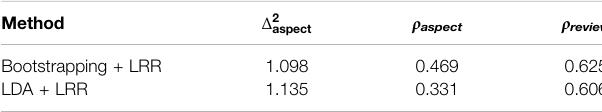
TABLE 4 | Accuracy assessment comparison between the “ bootstrapping + LRR ” method and “ LDA + LRR ”